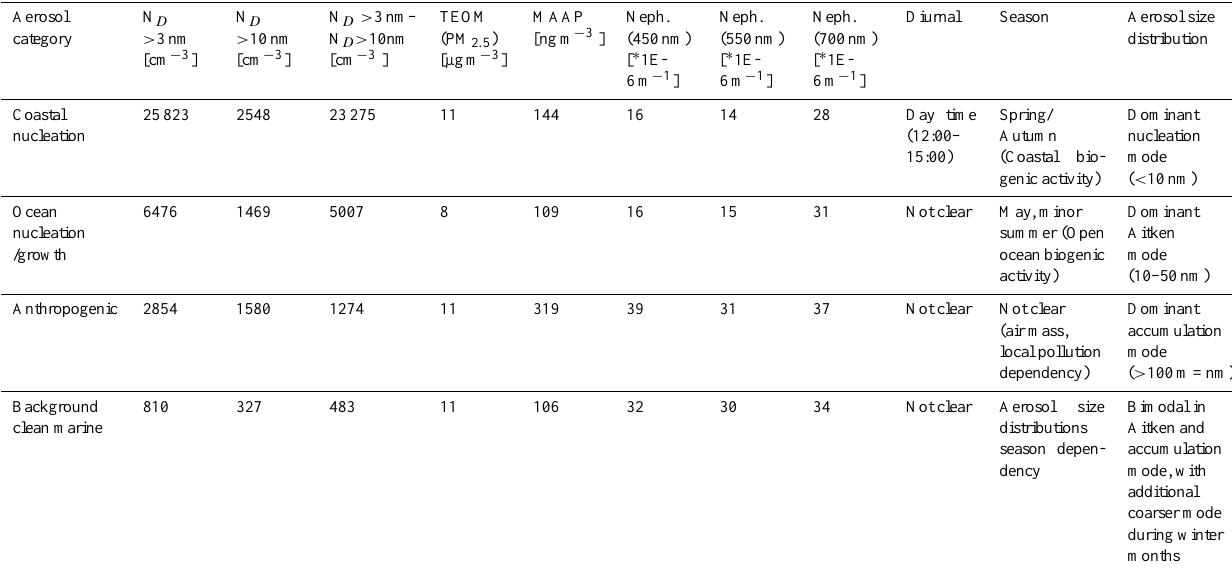
Table 4. Summary description of the four aerosol